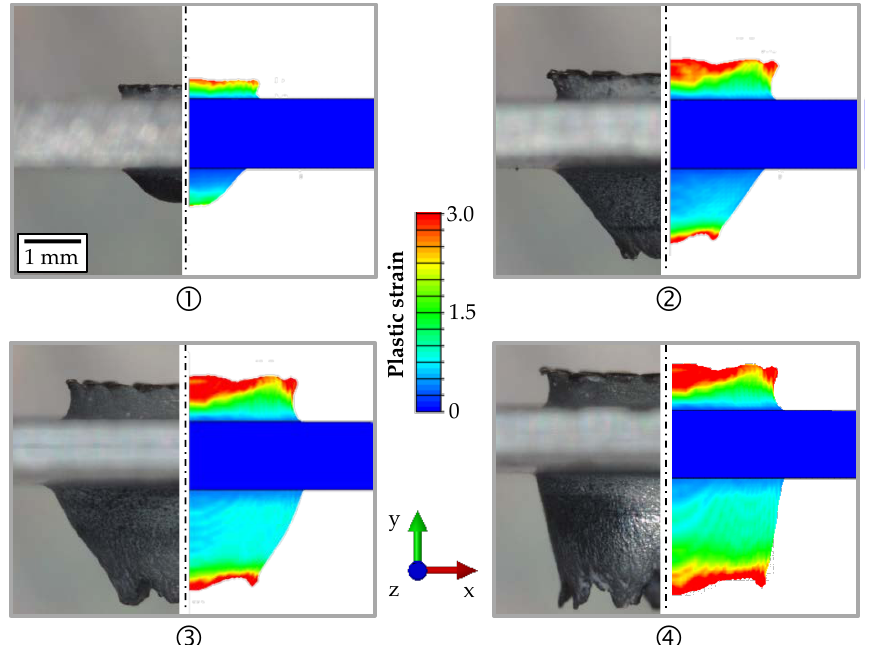
Figure 12. Comparison of the bushings for the experimental micrographs and the 3D FV simulation in the states: entering ( 1 ) and breakthrough ( 2 ) of the conical part of the friction drill; and entering ( 3 ) and breakthrough ( 4 ) of the cylindrical part for HX220 at a 1.2 mm sheet thickness.